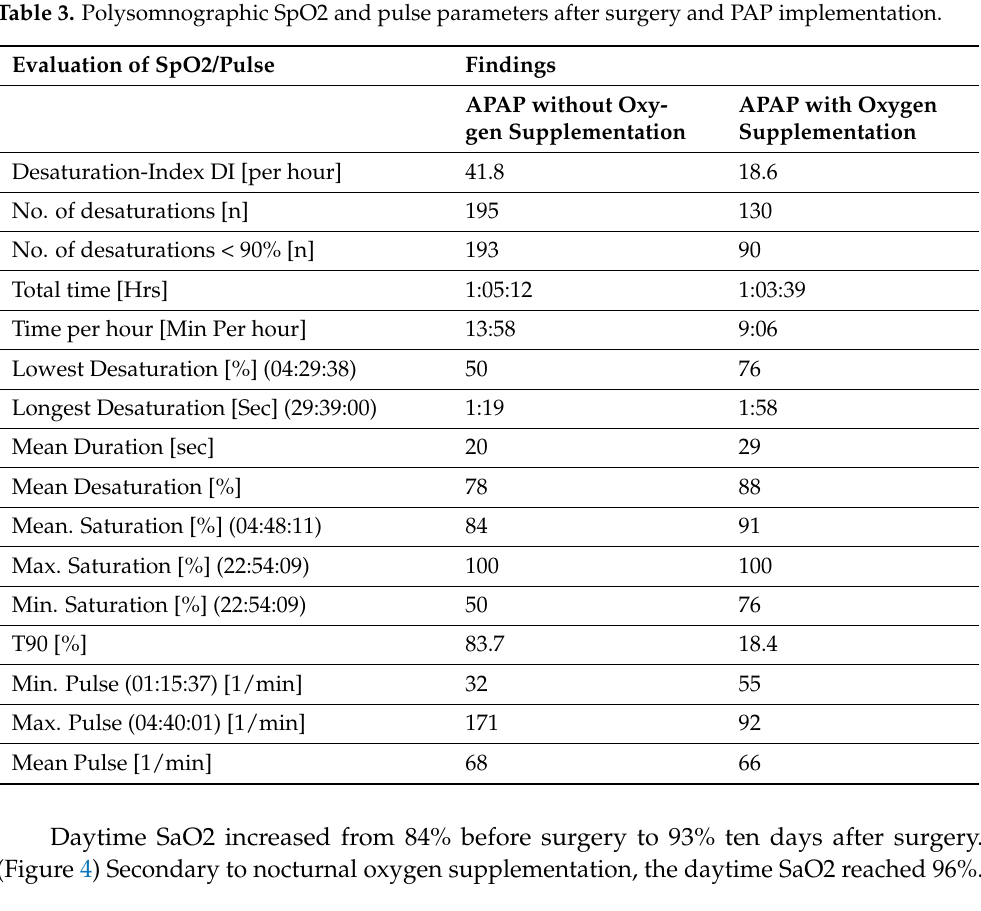
(Figure 4) Secondary to nocturnal oxygen supplementation, the daytime SaO2 reached 96%.